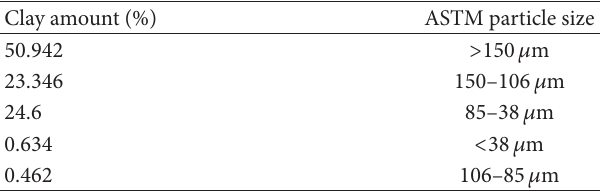
T 1: e analysis of particle size of montmorillonite clay.